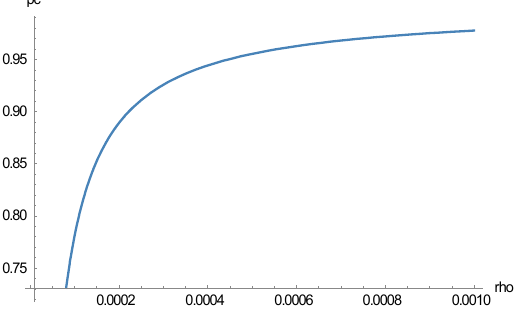
Figure 3. Tax compliance probability, p c , as a function of ρ .